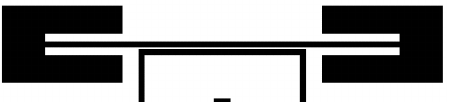
Figure 10. Layout of the implemented dipole